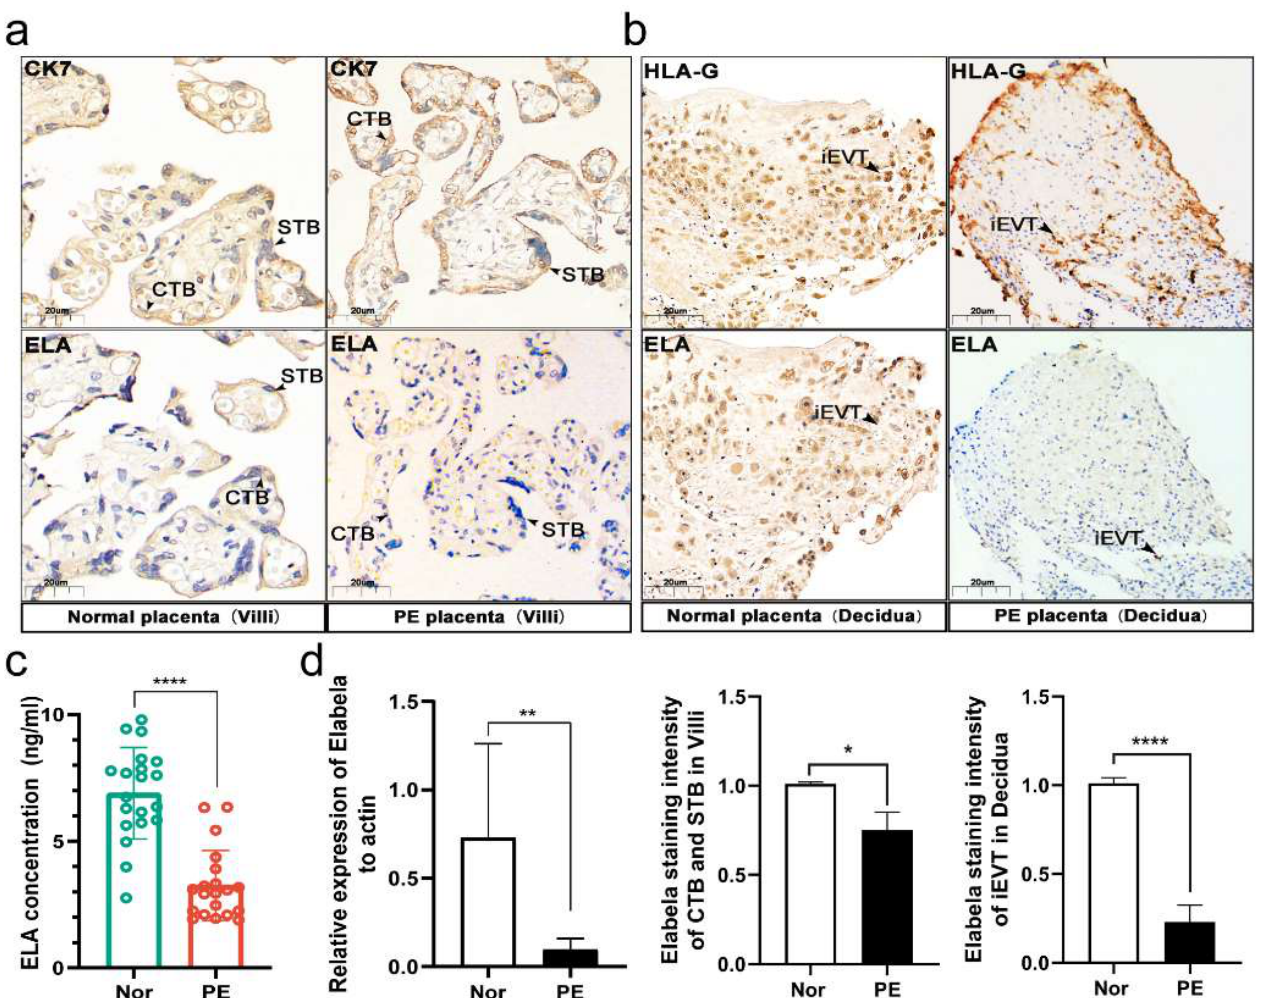
Figure 2. Low levels of Elabela in the placenta and circulation of the pregnancy with preeclampsia. Placental tissues and blood were collected from physiologically normal pregnancies ( n = 20) and PE pregnancies ( n = 20). ( a , b ) IHC staining of Elabela in human PE and normal placentas. Quantification of staining intensity per patient; n = 3. Scale bars: 20 μm, two-tailed t -test. ( c ) ELISA analysis of the expression of Elabela in the circulation of PE and normal pregnancies, two-tailed t -test. ( d ) RT-qPCR analysis of the expression of Elabela in preeclampsia and normal placentas, two-tailed t -test. ELA, Elabela. All data are presented as the means ± SEM. * p < 0.05; ** p < 0.01; **** p < 0.0001.